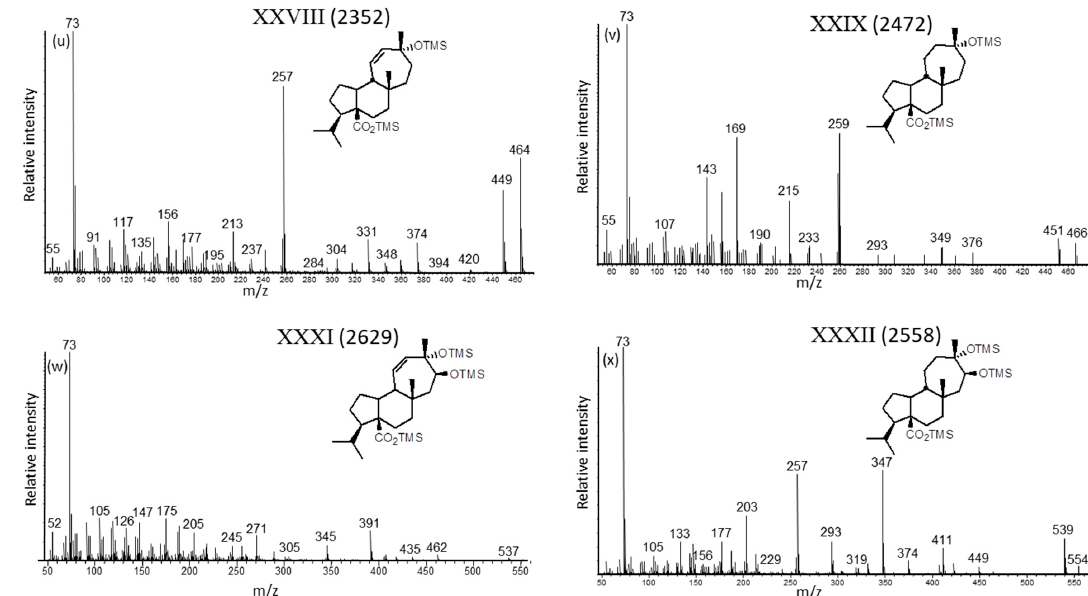
Figure 4. Mass spectra of the oxygenated diterpenoids in A. compacta resins, including KI values shown in parentheses: ( a ) 13 β‐ hydroxyazorellane (XVII), ( b ) 13 α‐ hydroxyazorellane (XVII), ( c ) 13 α‐ hydroxymulinane (XVIII), ( d ) 13 β (H) ‐ mulina ‐ 11,14 ‐ dien ‐ 20 ‐ oic acid (XIX, standard), ( e ) mulina ‐ 11,13 ‐